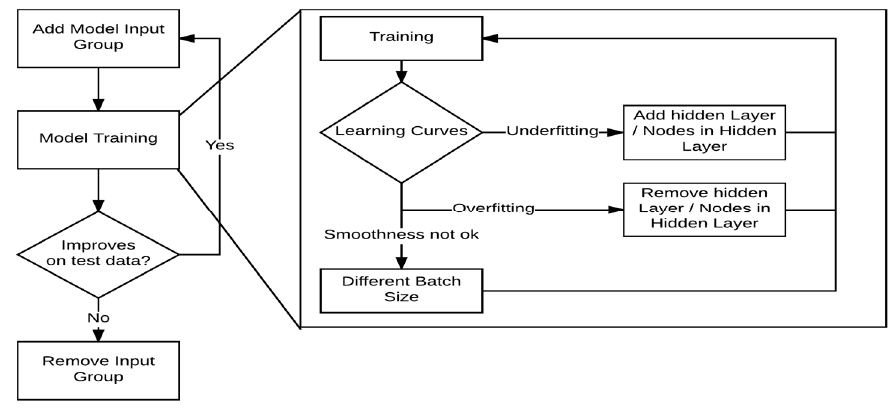
Figure 6. Search for MLP hyper parameters.